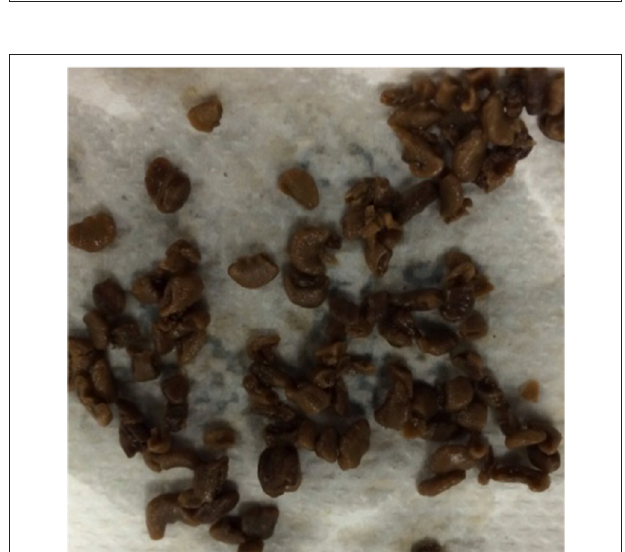
FIGURE 9 | The undigested hard kernels after enzymatic hydrolysis of DMR corn stover feedstock.